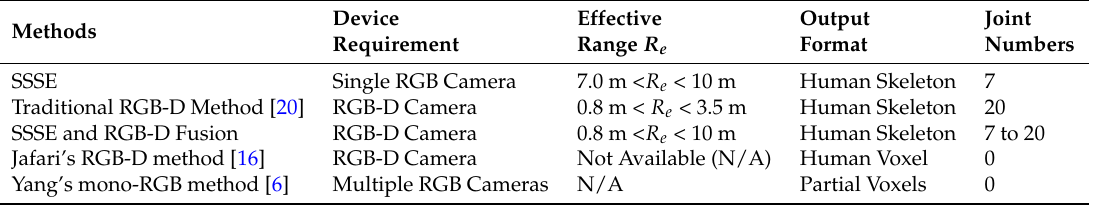
Table 2. Comparison between external sensor information-based quadcopter monitoring